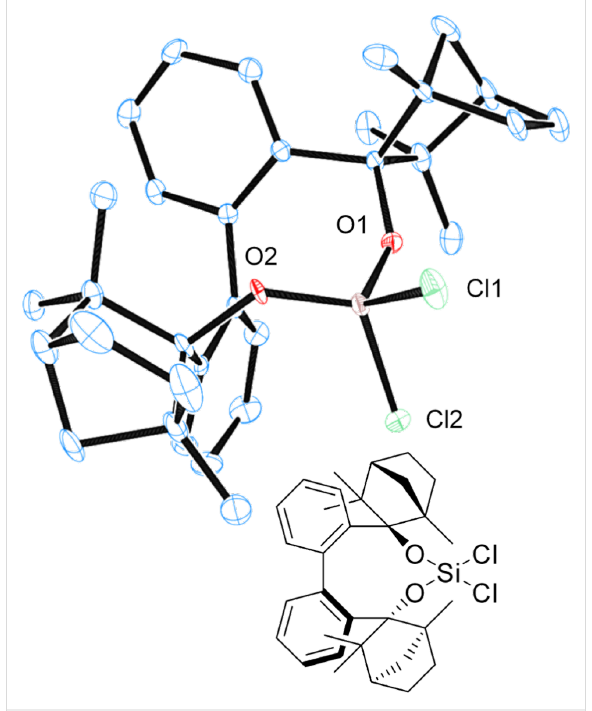
Figure 12: X-ray crystal structure of BIFOXSiCl 2 ( 7 ). H atoms on the chiral backbone are omitted for clarity issues and the ellipsoids are shown with 65% probability.